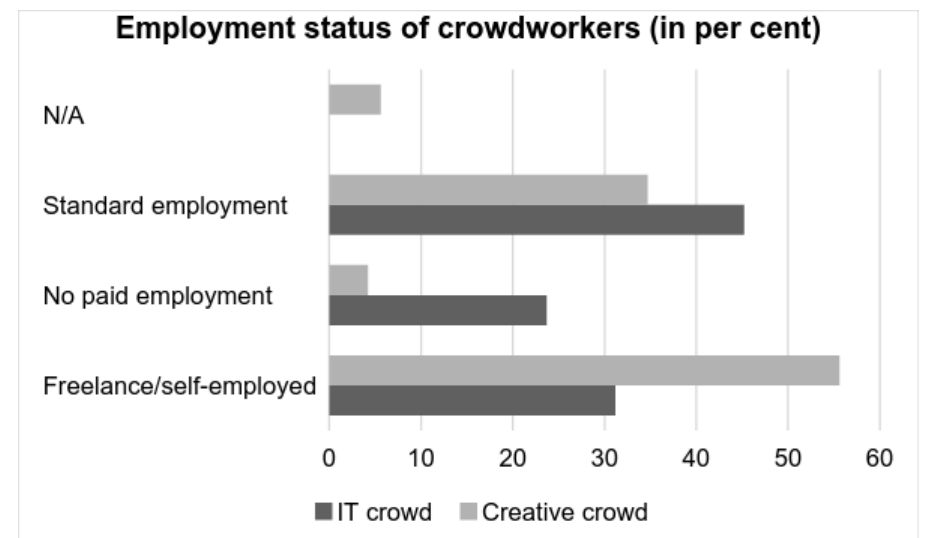
Figure 1: Employment status of crowdworkers (in per cent)